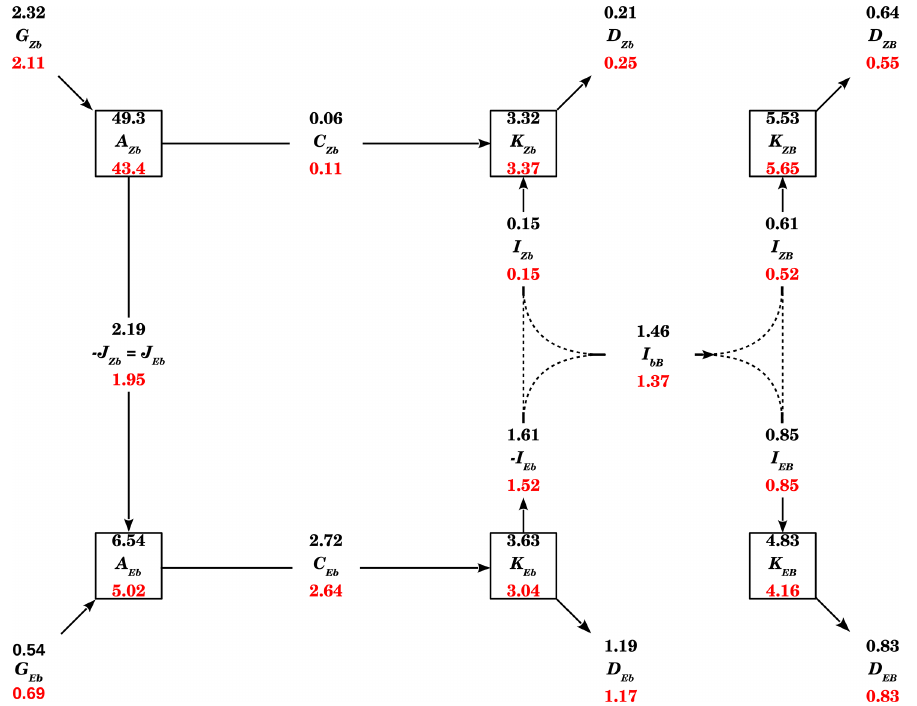
Figure 11. The same as in Fig. 10 but replacing lower boundary condition (14) with